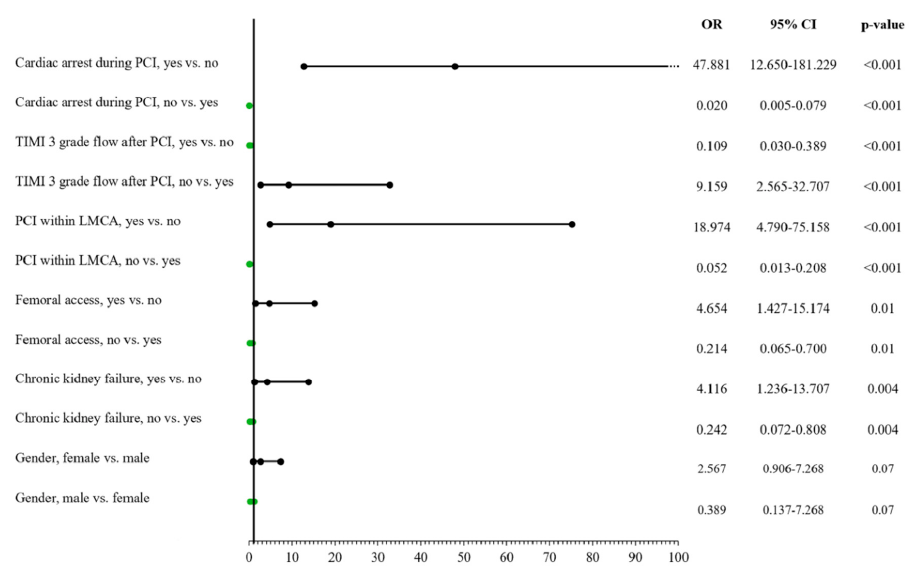
Figure 2. Risk factors for periprocedural death. LMCA: left main coronary artery; PCI: percutaneous coronary intervention; TIMI: Thrombolysis in Myocardial Infarction.